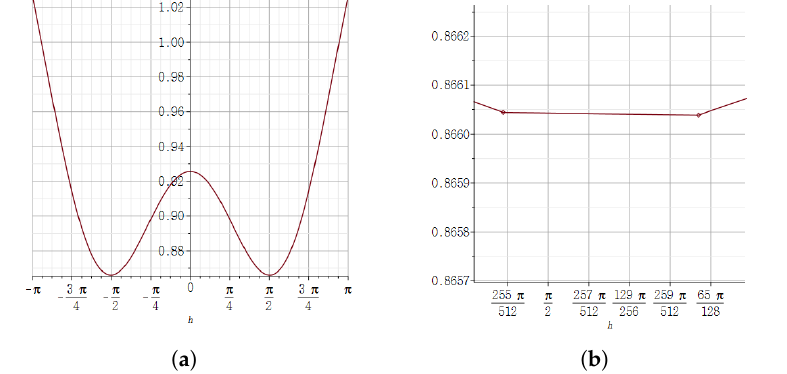
Figure 2. ( a ) The result of expressing the value of the relative error of the quaternion j -step derivative of e z at z 0 on the vertical axis according to the size of the horizontal axis h using the Maple plot. ( b ) In the graph of ( a ), the result of zooming in about h near π error is to